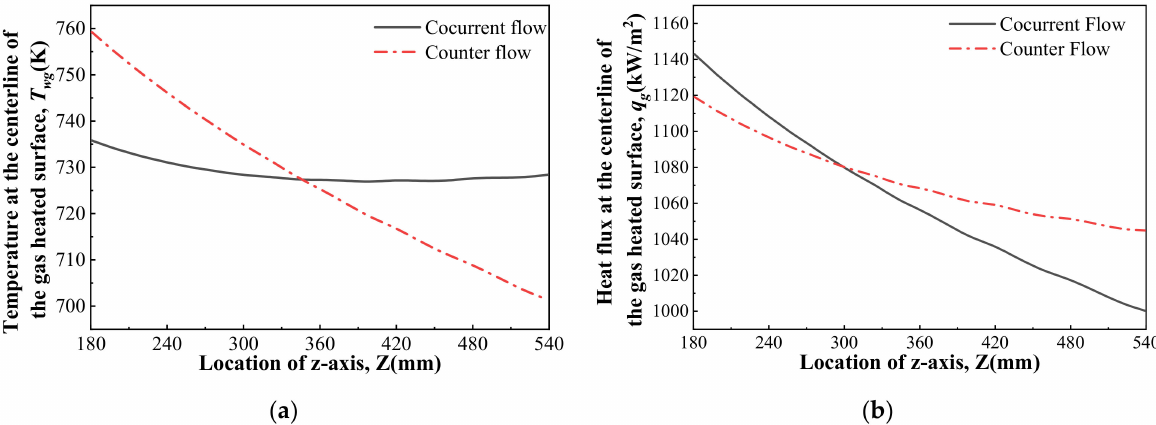
Figure 14. Variation of wall temperature T wg and heat flux q g at the centerline of the gas heated surface in cocurrent and counter flow: ( a ) T wg ( b ) q g